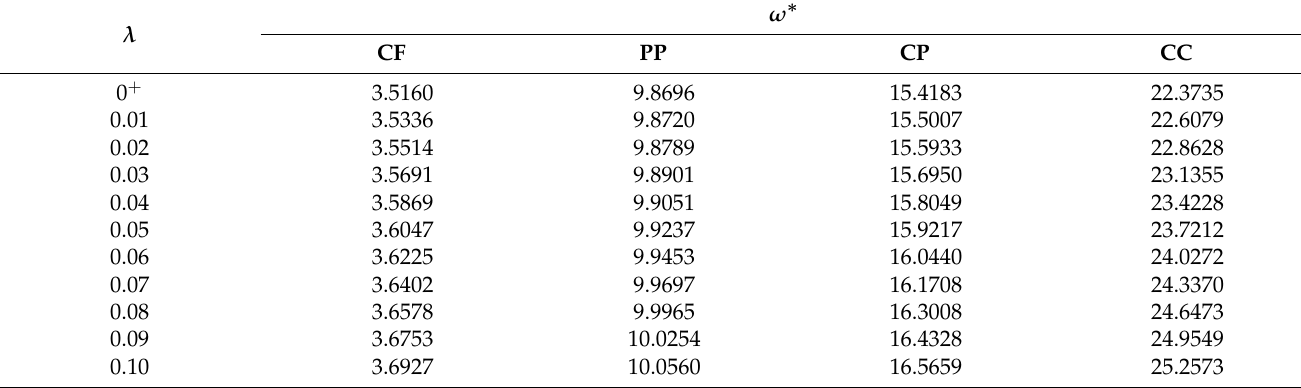
Table 5. Non-dimensional fundamental natural frequencies [ ω ∗ = ω 1 L 2 clamped-pinned (CP) and clamped-clamped (CC) beams, for α =